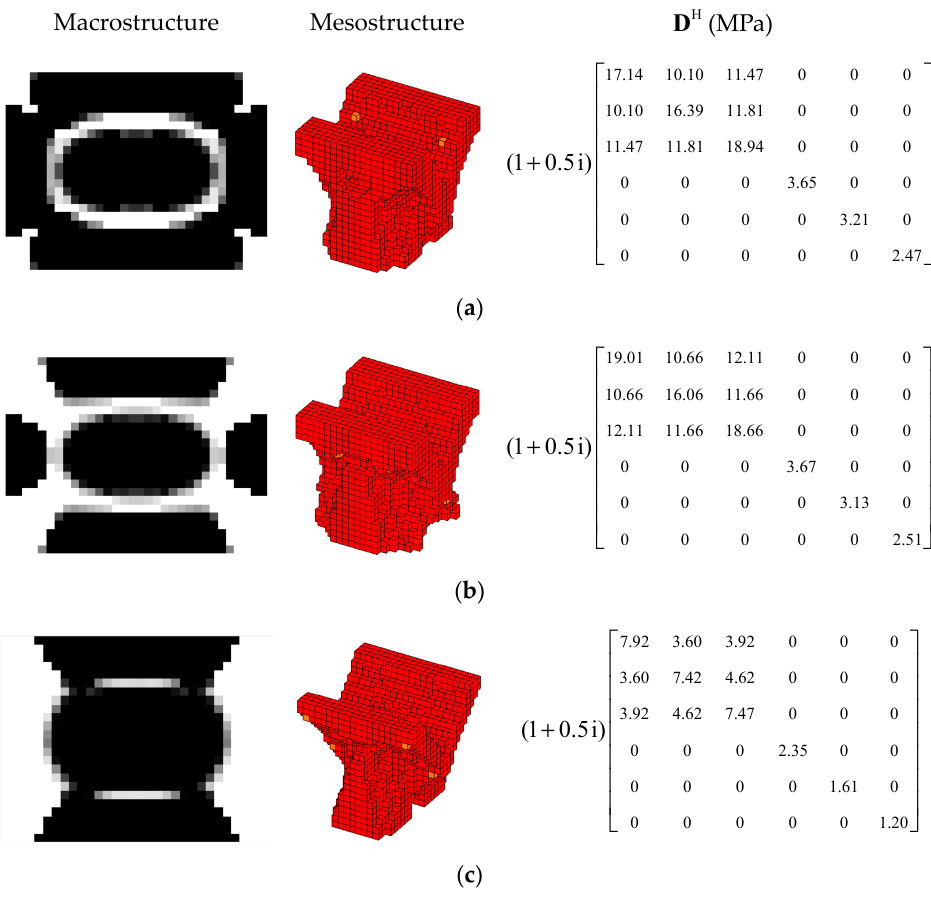
Figure 15. Design results for maximizing the first modal loss factor: ( a ) Case 1: V MA V MI f Table 4. The modal loss factors of the optimal designs (bold italics represent the modal loss factor of objective